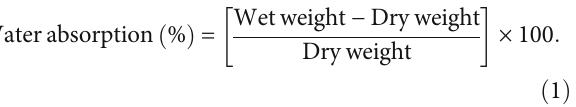
Figure 2: Tensile test analysing